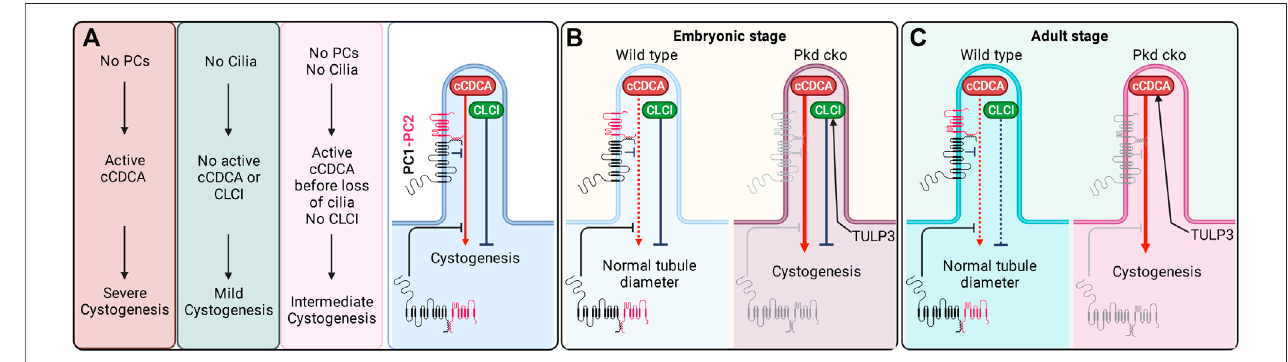
FIGURE5| Dualrolesofciliaincystogenesis. (A) Thegeneticdata( Figures1 , 4 )implies (i) cilia-localizedcilia-dependentcystactivation( cCDCA) signal(s)inhibited byPC1/2inboththecellbodyandciliumand (ii) independentcilia-localizedcystinhibition( CLCI )signal(s). (B) Intheembryonicstages,thecCDCAisnormallyweakand suppressed by polycystins. However, in the absence of polycystins, cCDCA is enhanced. TULP3 likely traf fi cs components of the CLCI. (C) In the adult stage, the inhibitory arm is weaker and a lack of polycystins is suf fi cient to lead to strongly activated cCDCA. TULP3 likely traf fi cs components of the cCDCA. Created in